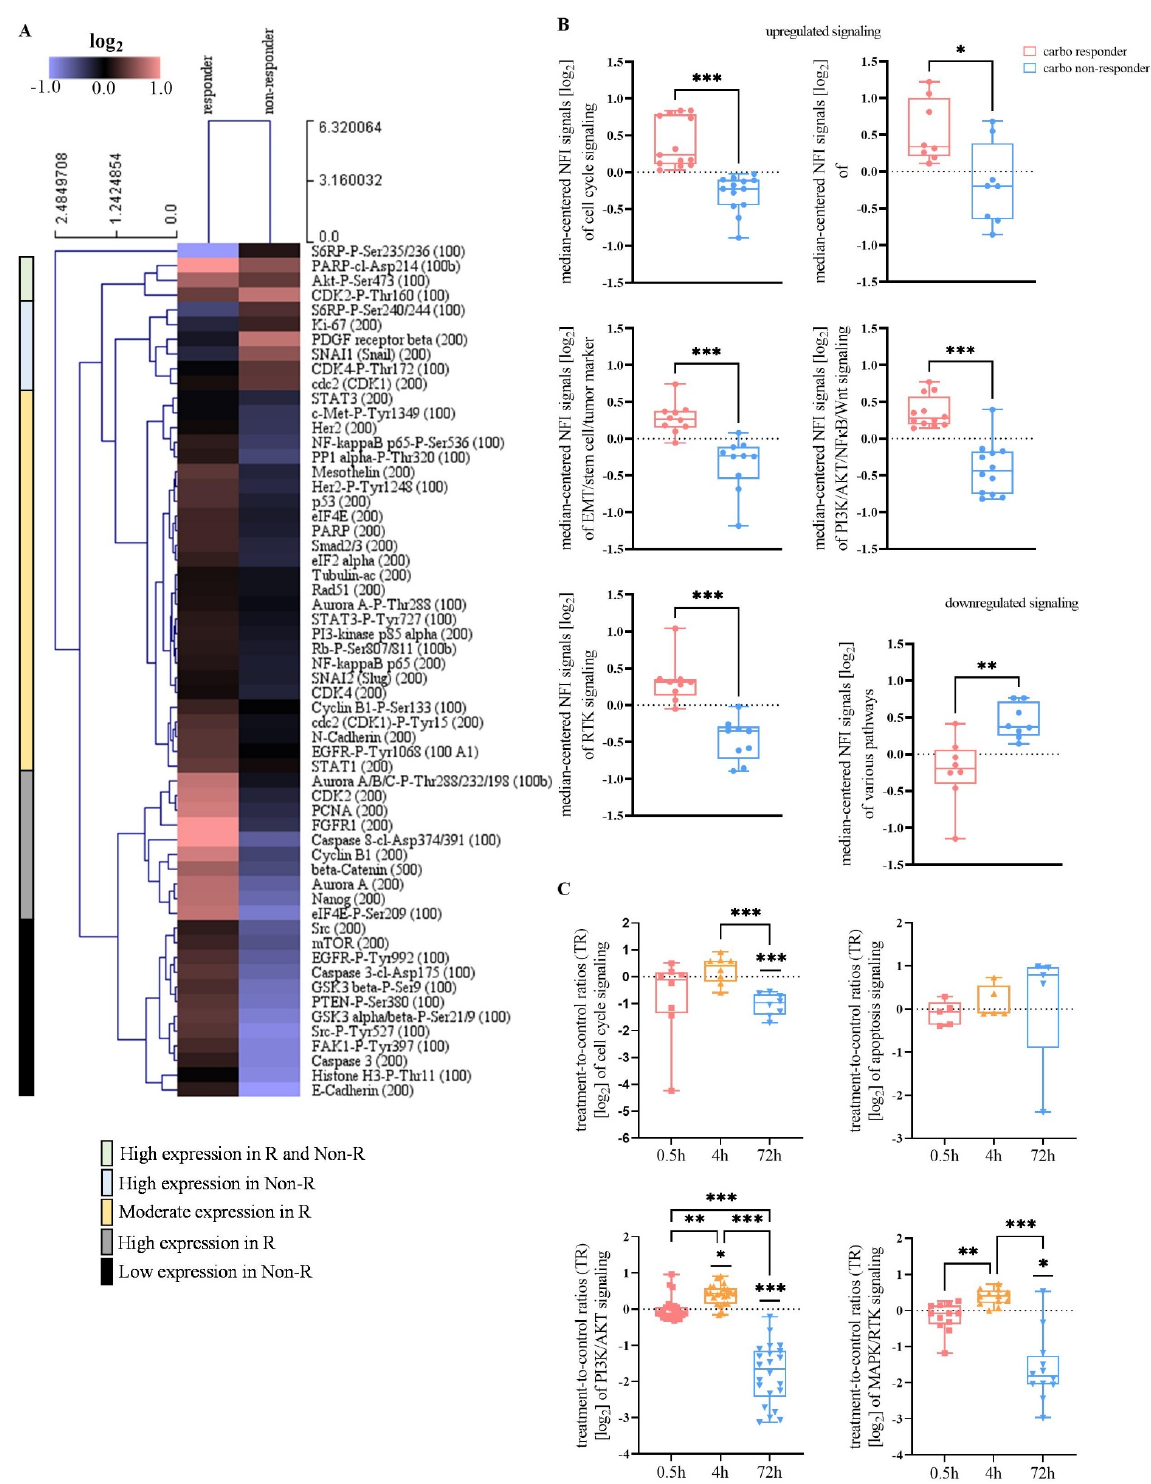
Figure 4. Carboplatin drug response in OvCa PDM correlates with the activity of diverse signaling pathways. ( A ) Heat map of protein abundances (calculated from median-centered NFI values) averaged over carboplatin-responder (R) and non-responder (Non-R) OvCa PDM. Carboplatin responders